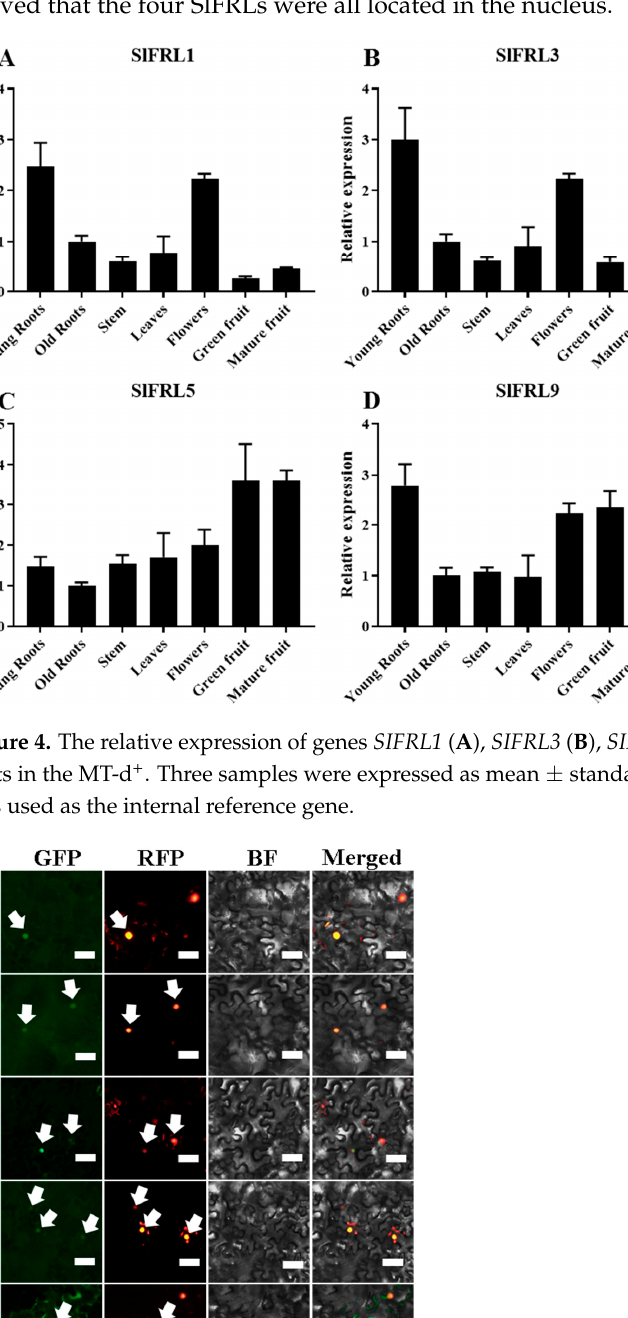
excitation of green fluorescence. While under excitation of red fluorescence, nuclear fluo ‐ rescence also appeared. The nuclear fluorescence under GFP all coincided with those un ‐ der RFP, which proved that the four SlFRLs were all located in the nucleus.